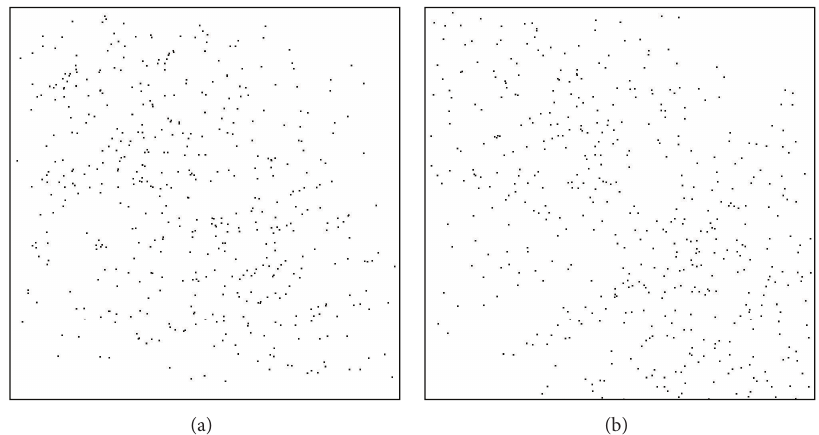
Figure 2: Two distributions generated with 500 points and the same probabilities and factors ( 𝑝 1 = 0.29 , 𝑝 2 = 0.21 , 𝑝 3 = 0.29 , 𝑝 4 = 0.21 , = 0.7 , 𝑟 = 0.5 , 𝑟 = 0.7 , and 𝑟 = 0.5 𝑟 1 2 3 4